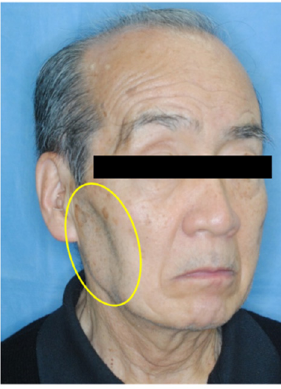
Figure 1. Atrophy of the right side of the masseter muscle.